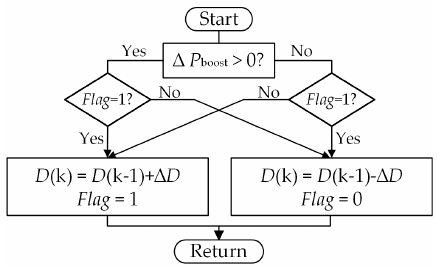
Figure 13. Flowchart of the perturb & observation (P&O) algorithm.